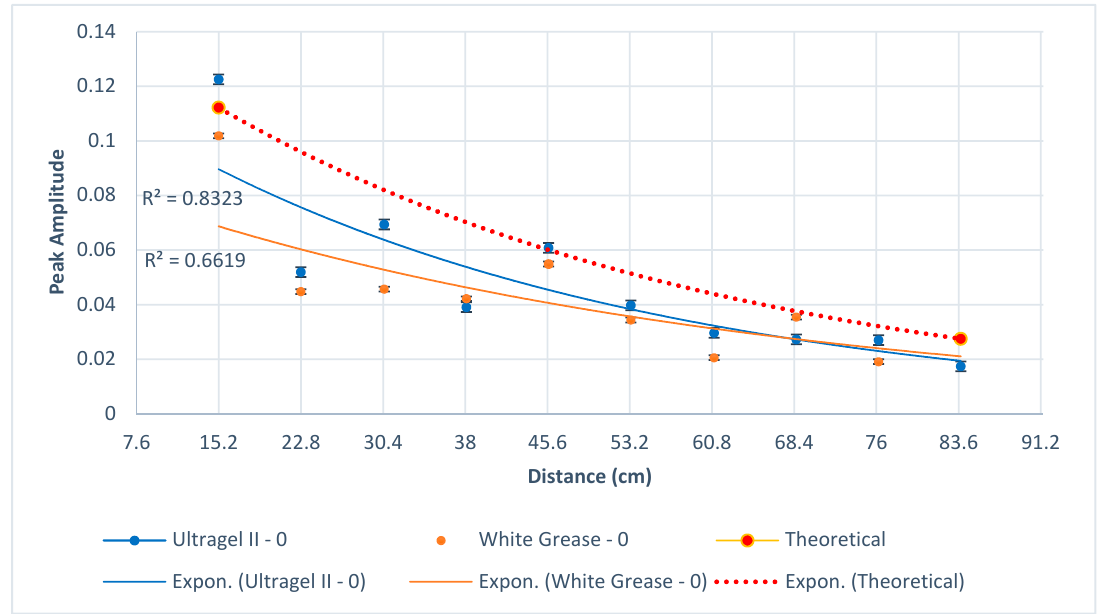
Figure 17. Plot obtained from the 0 degree specimen for comparison between Ultragel II and White Lithium Grease.